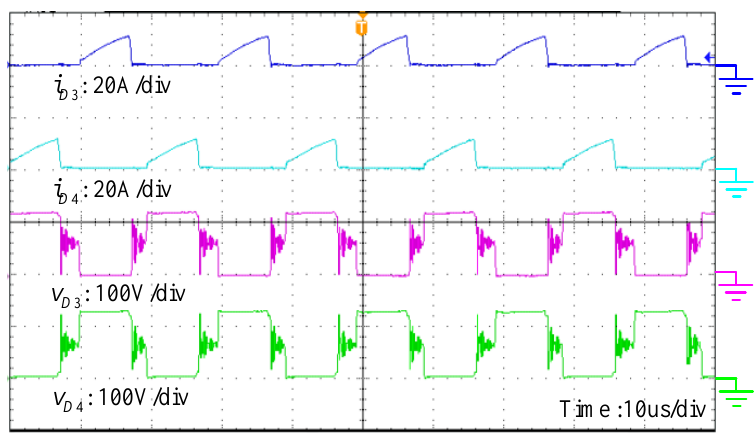
Figure 15. Measured waveforms of the voltages and currents on the switched diodes.